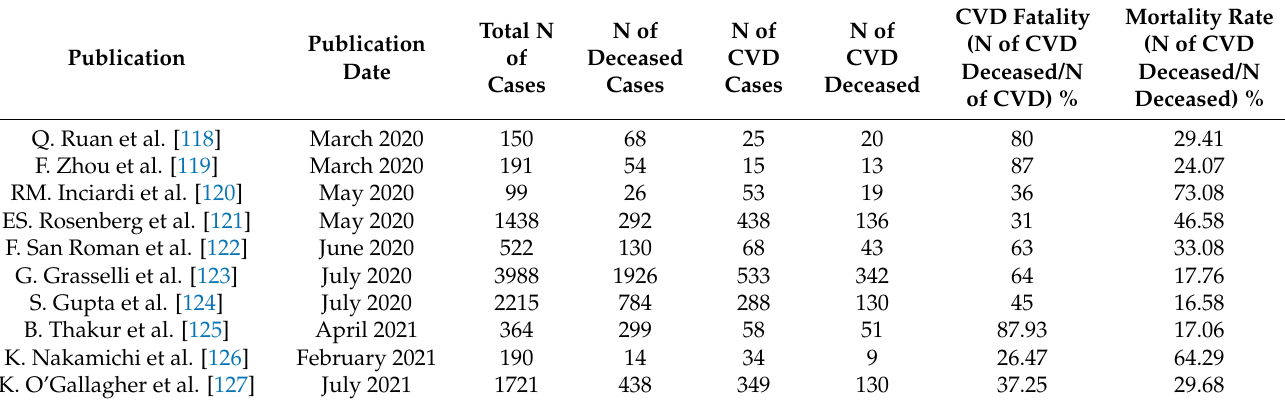
Table 1. Mortality rate of pre-existing cardiovascular disease (CVD) as a risk factor in COVID-19